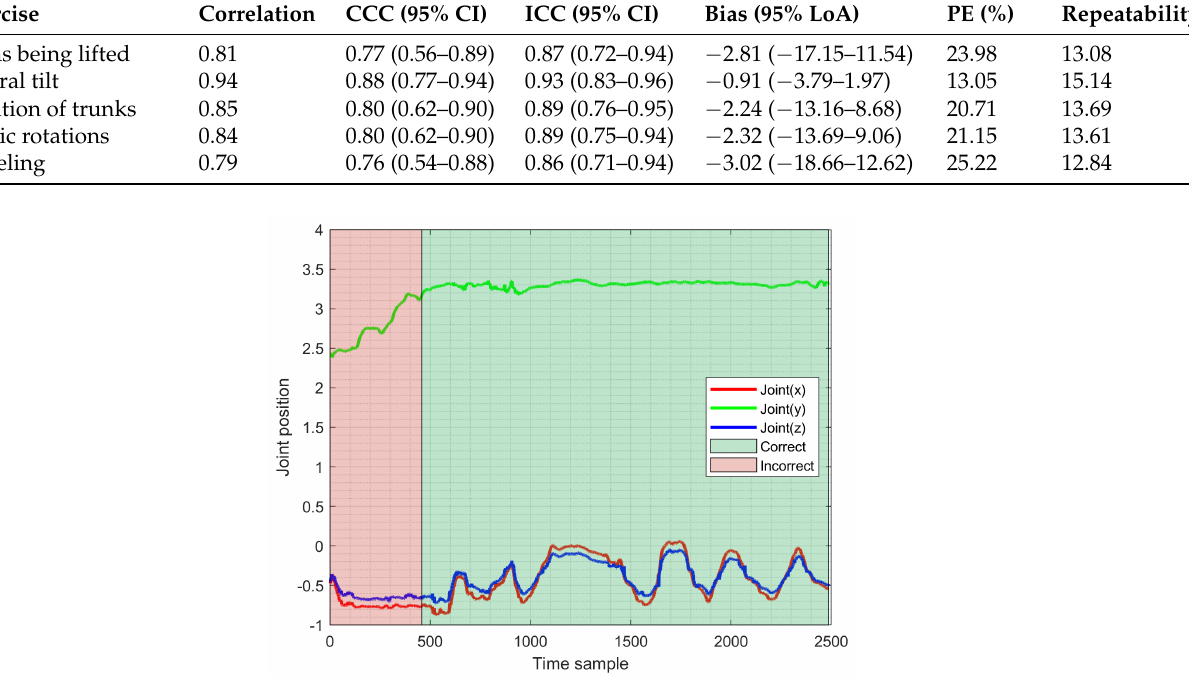
Figure 18. Plot of correctly and incorrectly performed